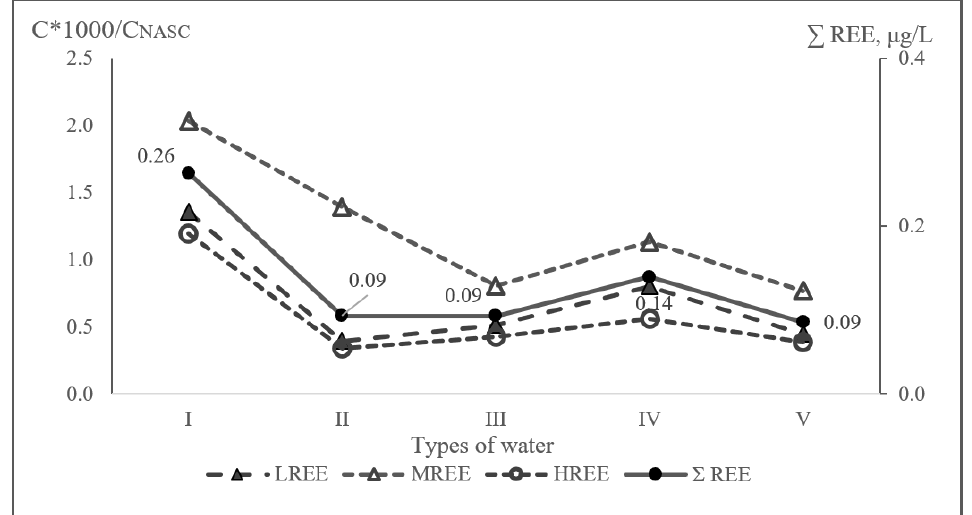
Figure 3. REE concentration spectra normalized to the North American Shale Composite (NASC) [53,54] and total REEs in various groundwater types.